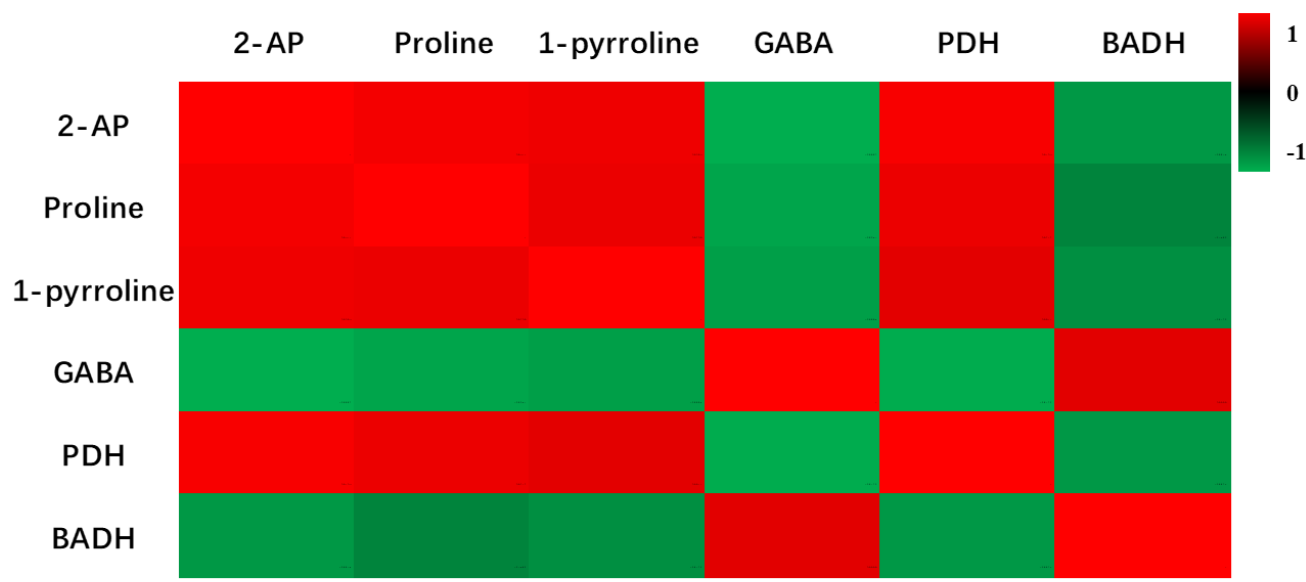
Figure 8. The heat map for 2-AP content, proline content, 1-pyrroline content, GABA content, PDH activity, and BADH